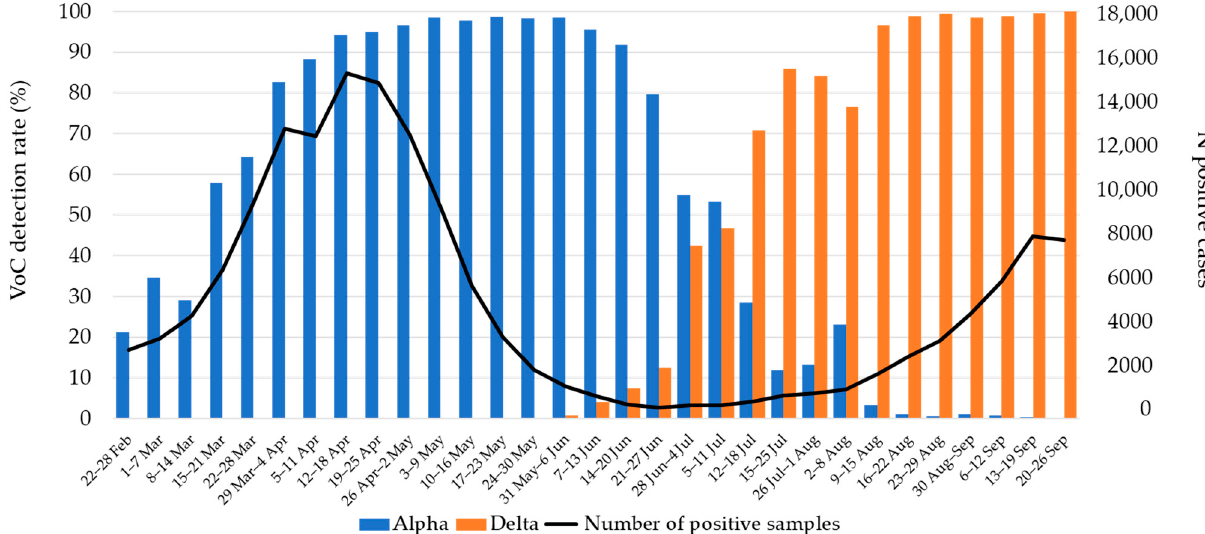
Figure 3. Prevalence of SARS-CoV-2 Alpha and Delta VoCs detected during the third and fourth epidemic wave in Croatia (February–September 2021).